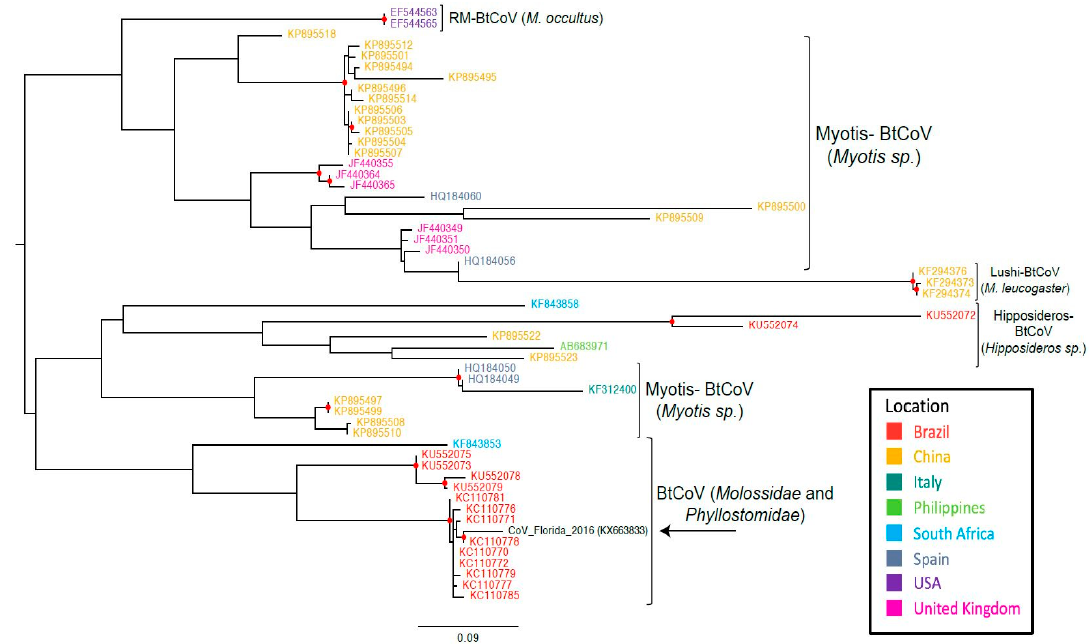
Figure 2. Maximum likelihood tree based on the nucleotide sequences of partial RdRp gene of bat CoVs. In parenthesis are the bat species that make up the clade. Abbreviations: BtCoV, bat coronavirus; Rm-BtCoV, Rocky Mountain bat coronavirus. Red circle indicates strong statistical support (bootstrap > 95%).